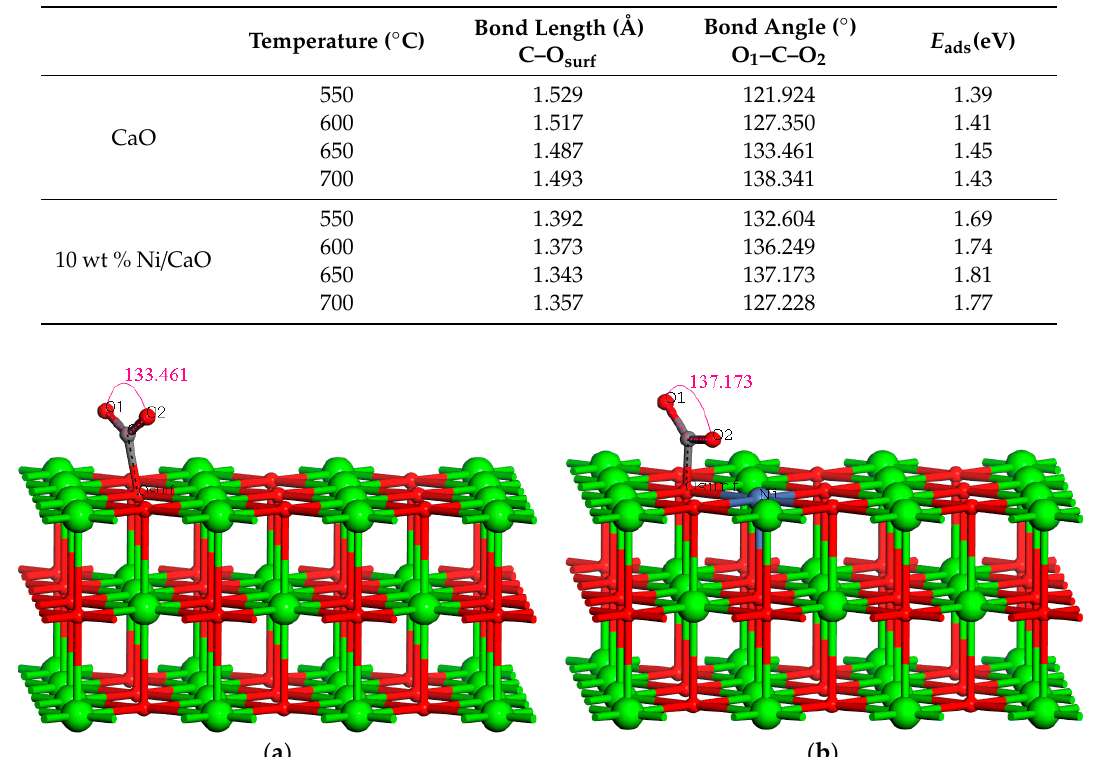
Table 1. Geometrical parameters and adsorption energies of CO 2 on catalysts’ surfaces at different temperatures.